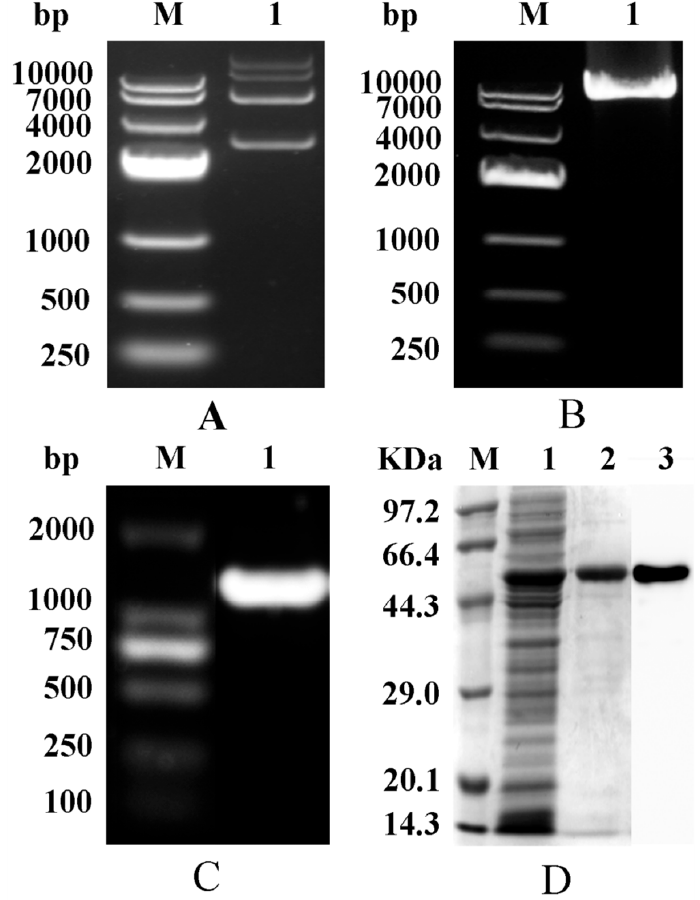
Figure 2. Structure and verification of AK. ( A ) Agarose gel electrophoresis of plasmid (PET-28a-AK). M: DNA marker; 1: WT-AK; ( B ) Agarose gel electrophoresis of the plasmid PCR. M: DNA marker; 1: A380I; ( C ) Agarose gel electrophoresis of bacterial PCR products. M: DNA marker; 1: A380I; ( D ) SDS-PAGE and Western Blot. M: protein marker; 1: crude enzyme sample; 2: purified A380I; 3: Western Blot.